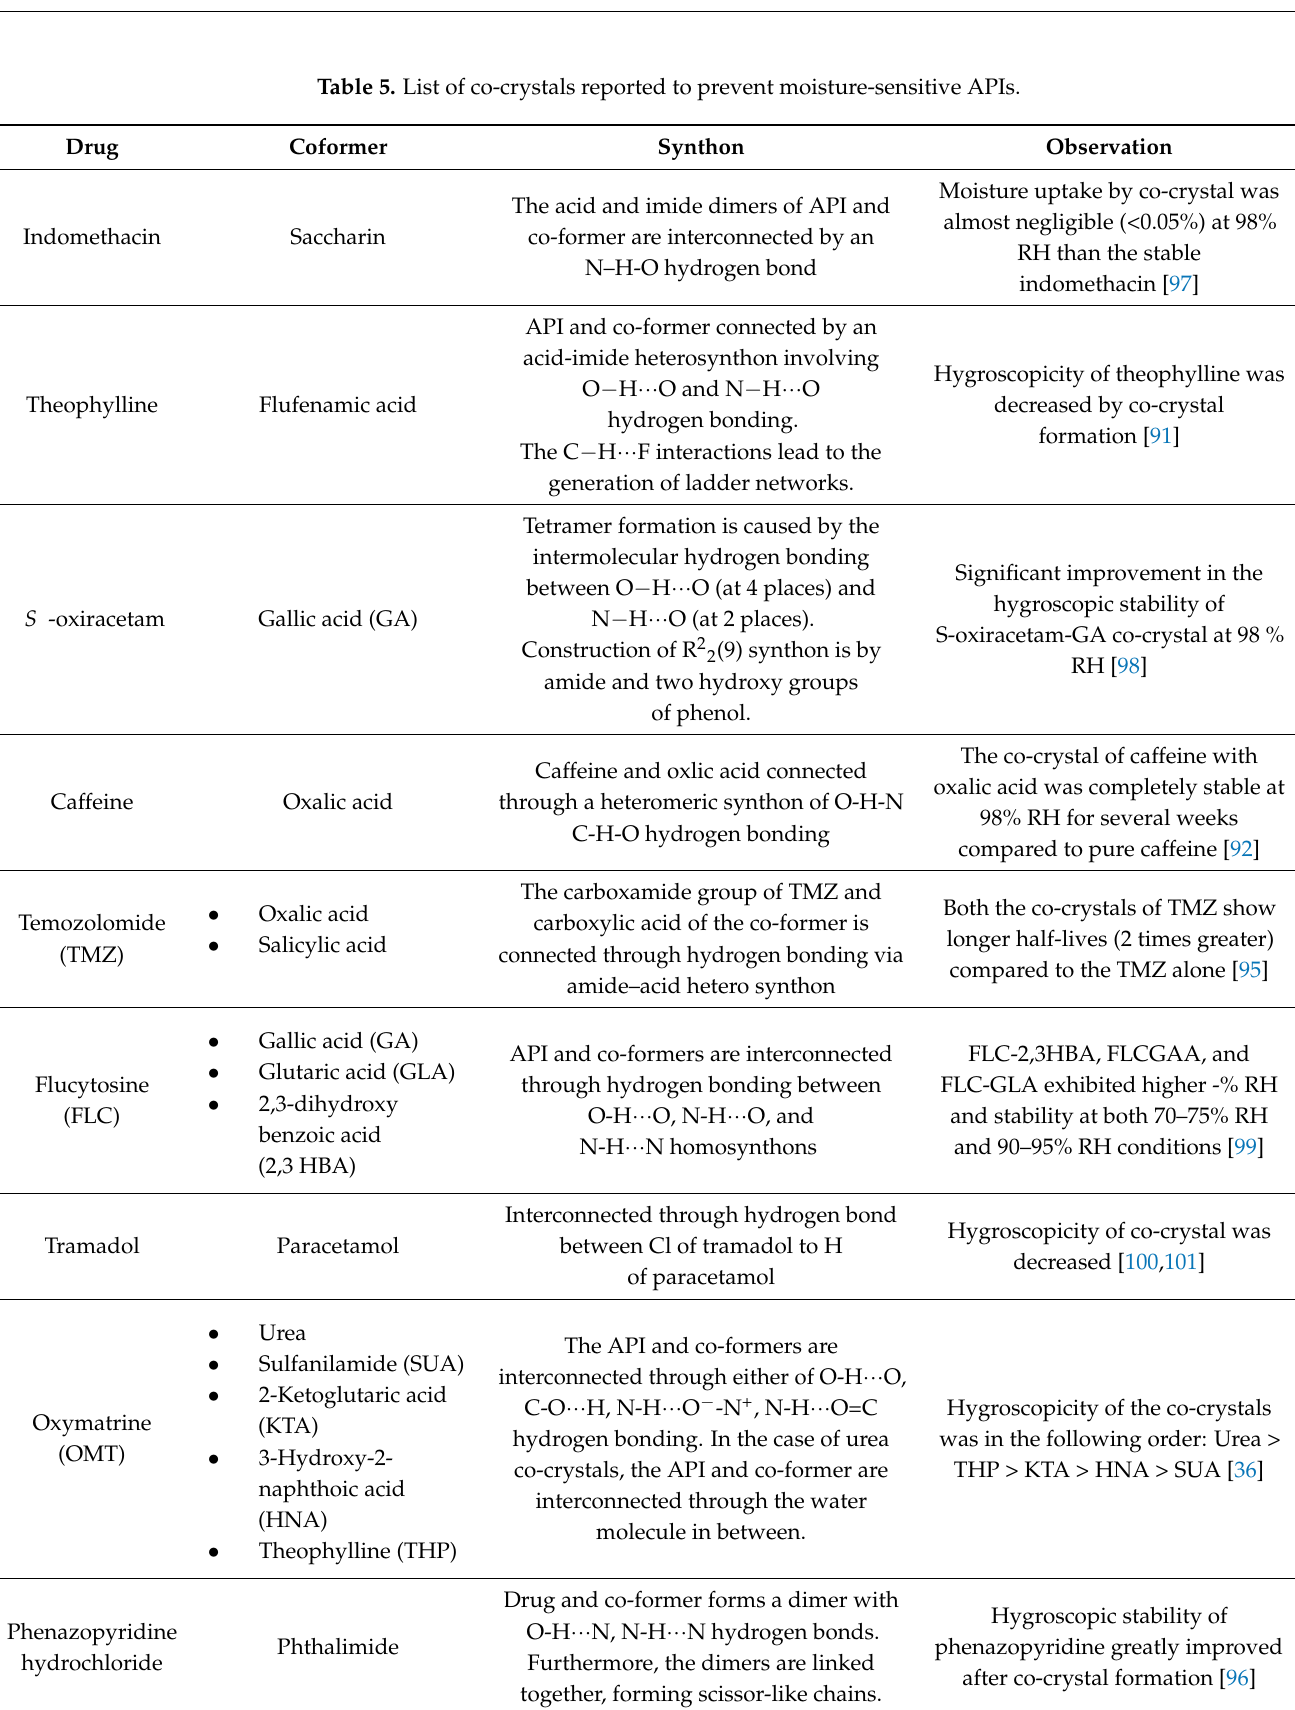
Table 5. List of co-crystals reported to prevent moisture-sensitive